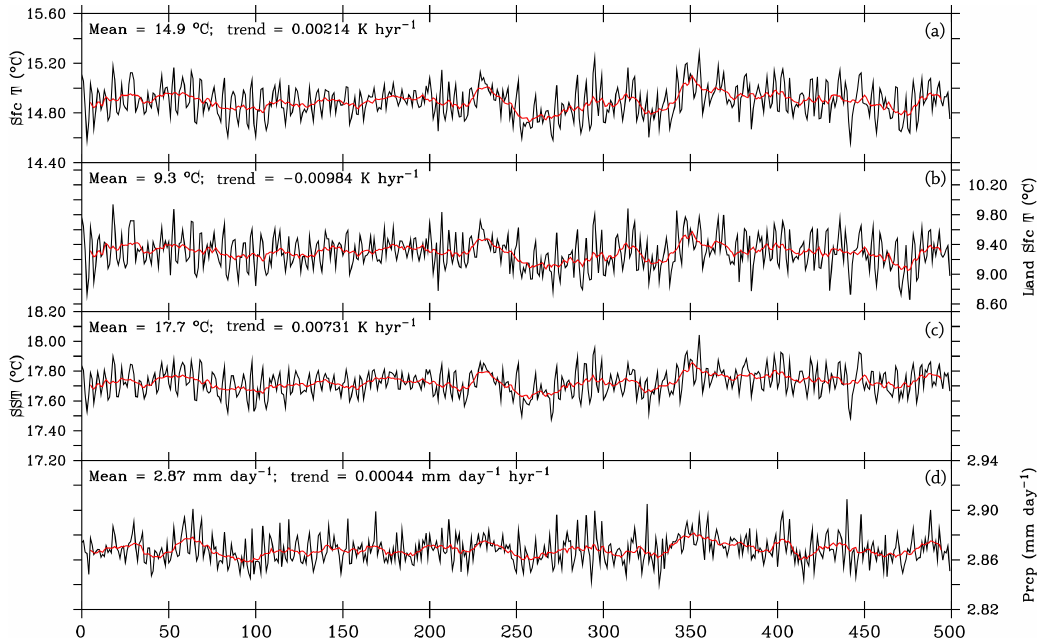
Figure 3. Results from the preindustrial control experiment. Annual mean time series of surface temperature and precipitation from year 0 to 500 in the preindustrial control experiment; from top: near-surface air temperature ( ◦ C), land surface temperature ( ◦ C), sea surface temperature ( ◦ C), and precipitation (mmday − 1 ). The long-term mean value and trend are indicated in the upper left corners. The black lines are annual mean values and the red lines are their 9-year running mean values.